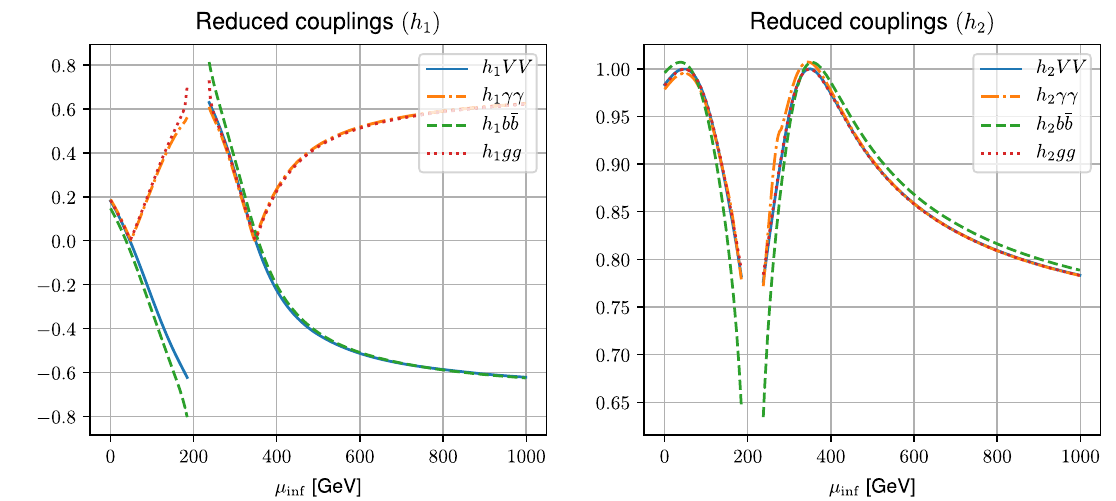
Fig. 3 The reduced couplings of h 1 and h 2 to gauge bosons, photons, b quarks and gluons, depending on μ inf Fig. 4 The lightest scalar Higgs production cross section at 250 GeV ILC depending